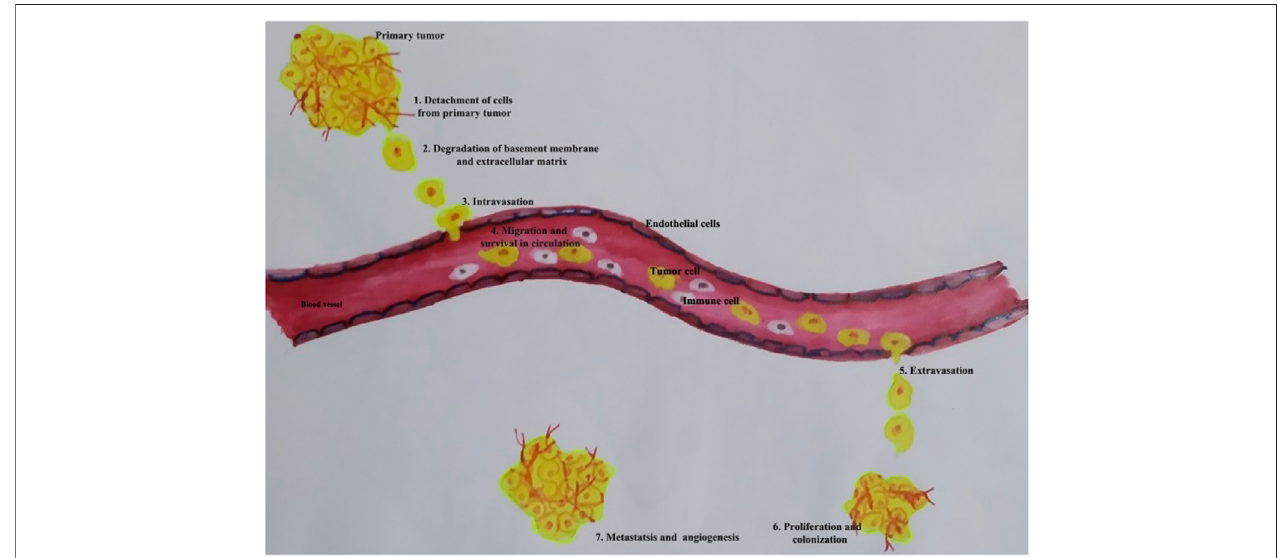
FIGURE 1 | Schematic overview of the essential steps of the